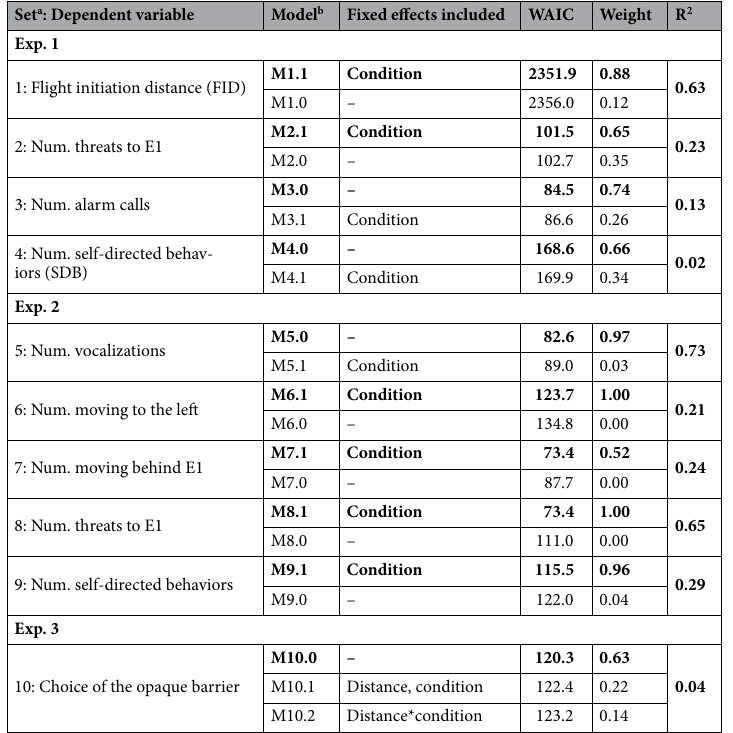
Table 1. List of the models used in this study, including the dependent variable, the number of the model as used in the text, the fixed effects, the Widely Applicable Information Criteria (WAIC), and the Akaike weight of each model. The R 2 shown corresponds to the best model in each set. Exp. = experiment, Num. = number, E1 = experimenter 1 a Each set of models has the same dependent variable. b The models in each set are ordered from the lowest to the highest WAIC, and the best model is presented in bold and accompanied with its R 2 coefficient. In all models, we also included a varying intercept by subject identity, as well as the fixed effect of subject’s age, sex, and rank as